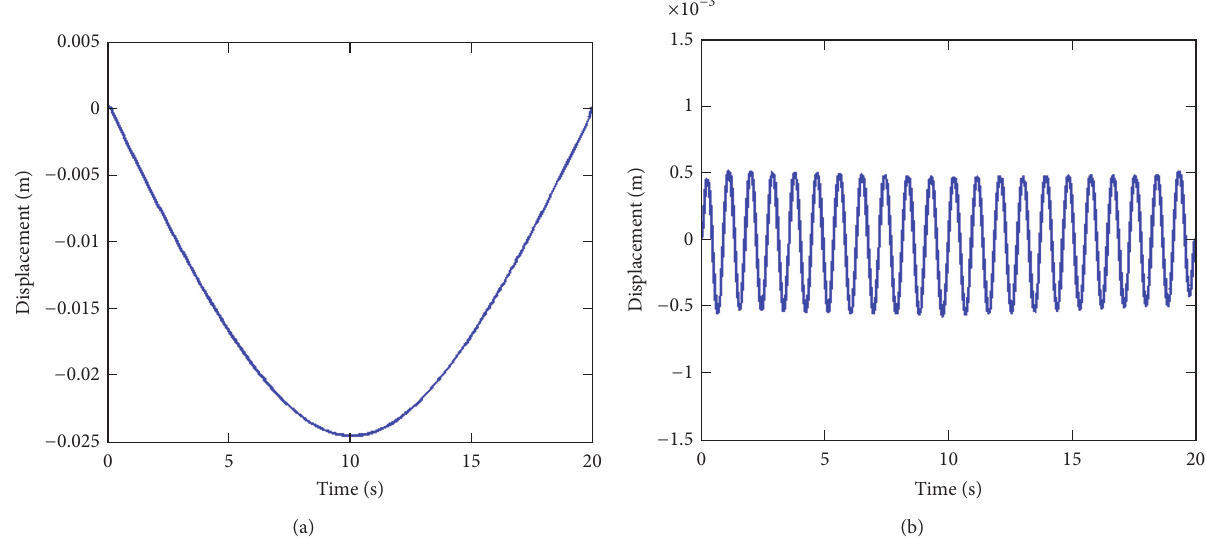
Figure 5: Displacement components of the undamaged beam with mass velocity for 1m/s: (a) the maintained component after using MFF twice and (b) the component with frequency for 1.07Hz.